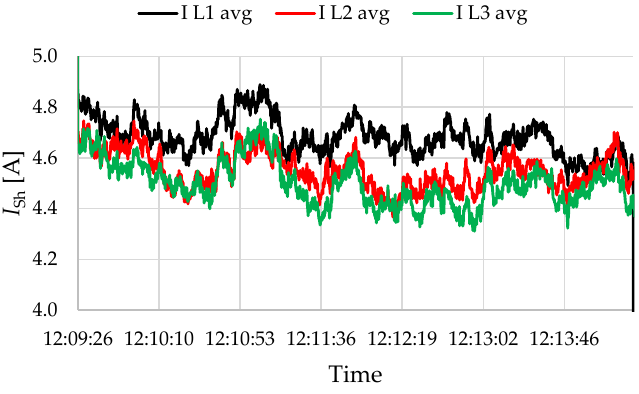
Figure 14. Sheaths currents measured in Substation 2. Sheaths cross-bonded according to: L1 → L2,